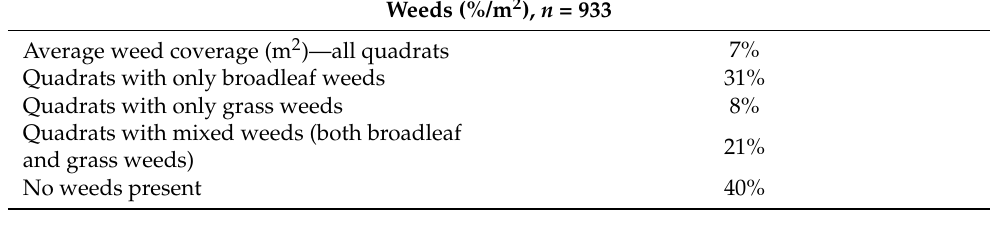
Table 3. Weed coverage in production areas.